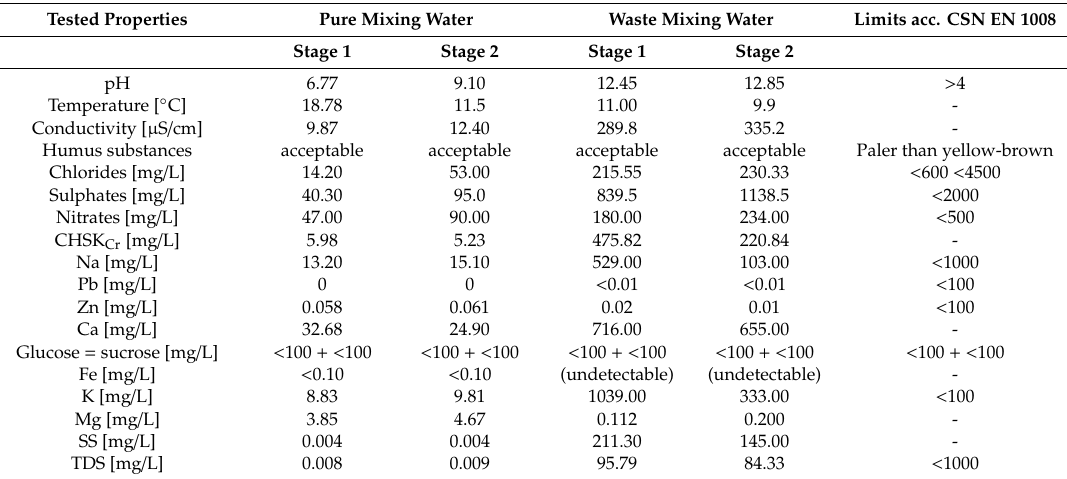
Table 1. Results of analyses of pure mixing water and recycled waste sludge water from the concrete plant